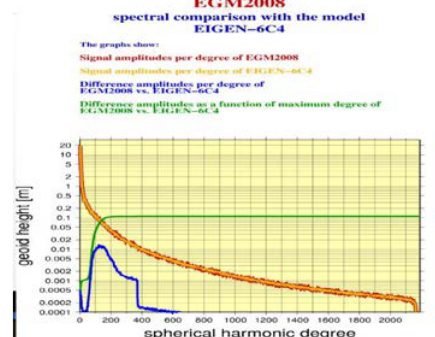
Figure 1. Spectral Comparison of EGM 2008 with the Model EIGEN-6C4 (ICGEM,